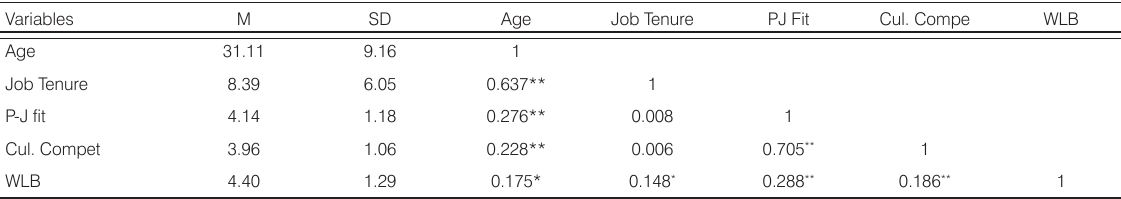
Table 1. Descriptive Statistics and Correlation